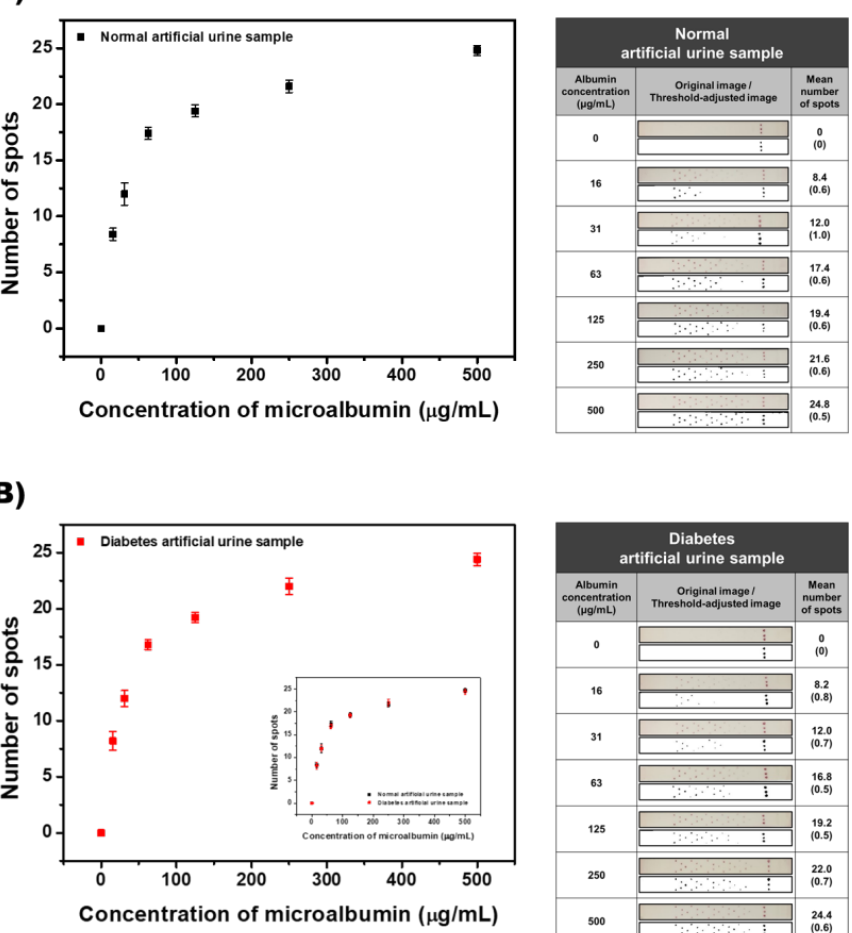
Figure 6. Quantitative analysis of microalbumin-spiked artificial urine and diabetes urine samples. ( A ) The calibration curve of microalbumin at various concentrations in the artificial urine samples. Original and threshold-adjusted images of the strip. ( B ) The calibration curve of microalbumin at various concentrations in the artificial diabetes urine samples. Original and threshold-adjusted images of the strip. The two calibration curves are overlapped in the inset graph. The SD values are shown in parentheses.